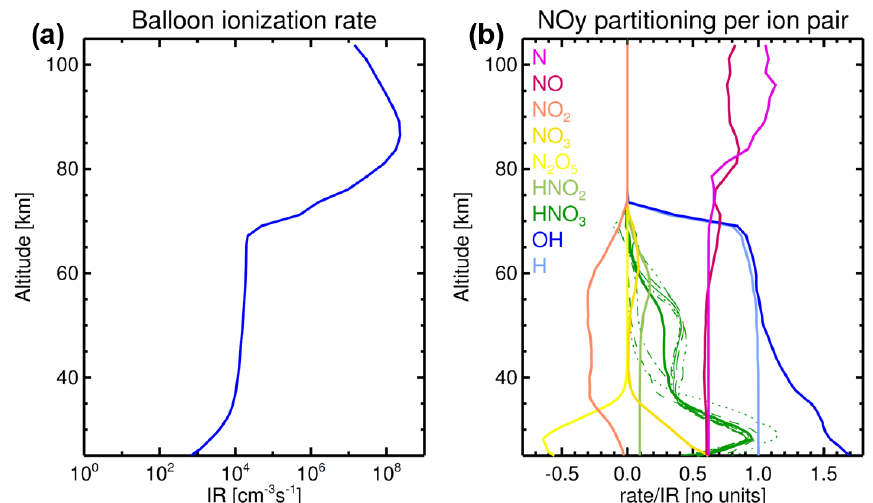
Figure 6. (a) The atmospheric ionization profile derived from the balloon observations on 14 December 2009 over Moscow. (b) Mean formation and loss rates of NO y species due to ion chemistry calculated hourly from 12:00–20:00UTC over Moscow with the ExoTIC ion chemistry model, showing the formation of N, NO, H and OH, as well as the repartitioning of NO y species from NO 2 and N 2 O 5 to NO 3 , HNO 2 and HNO 3 . For HNO 3 , individual hourly values are also shown in different line styles to highlight the strong diurnal variability, with distinctly higher values in the 35–60km region during